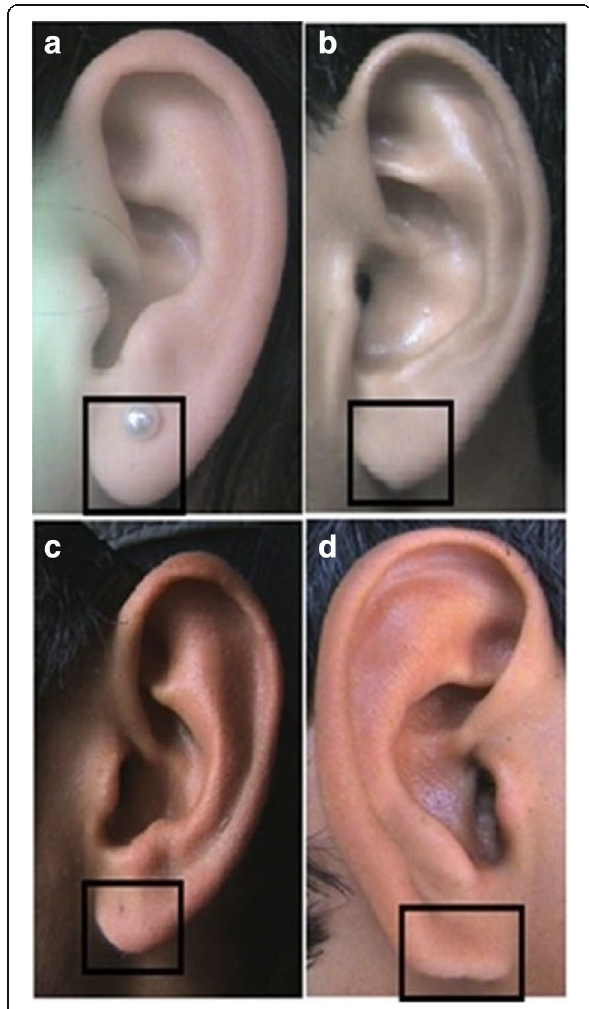
Fig. 4 Photographs showing the different shapes of the earlobe. a Tongue. b Triangular. c Arched. d